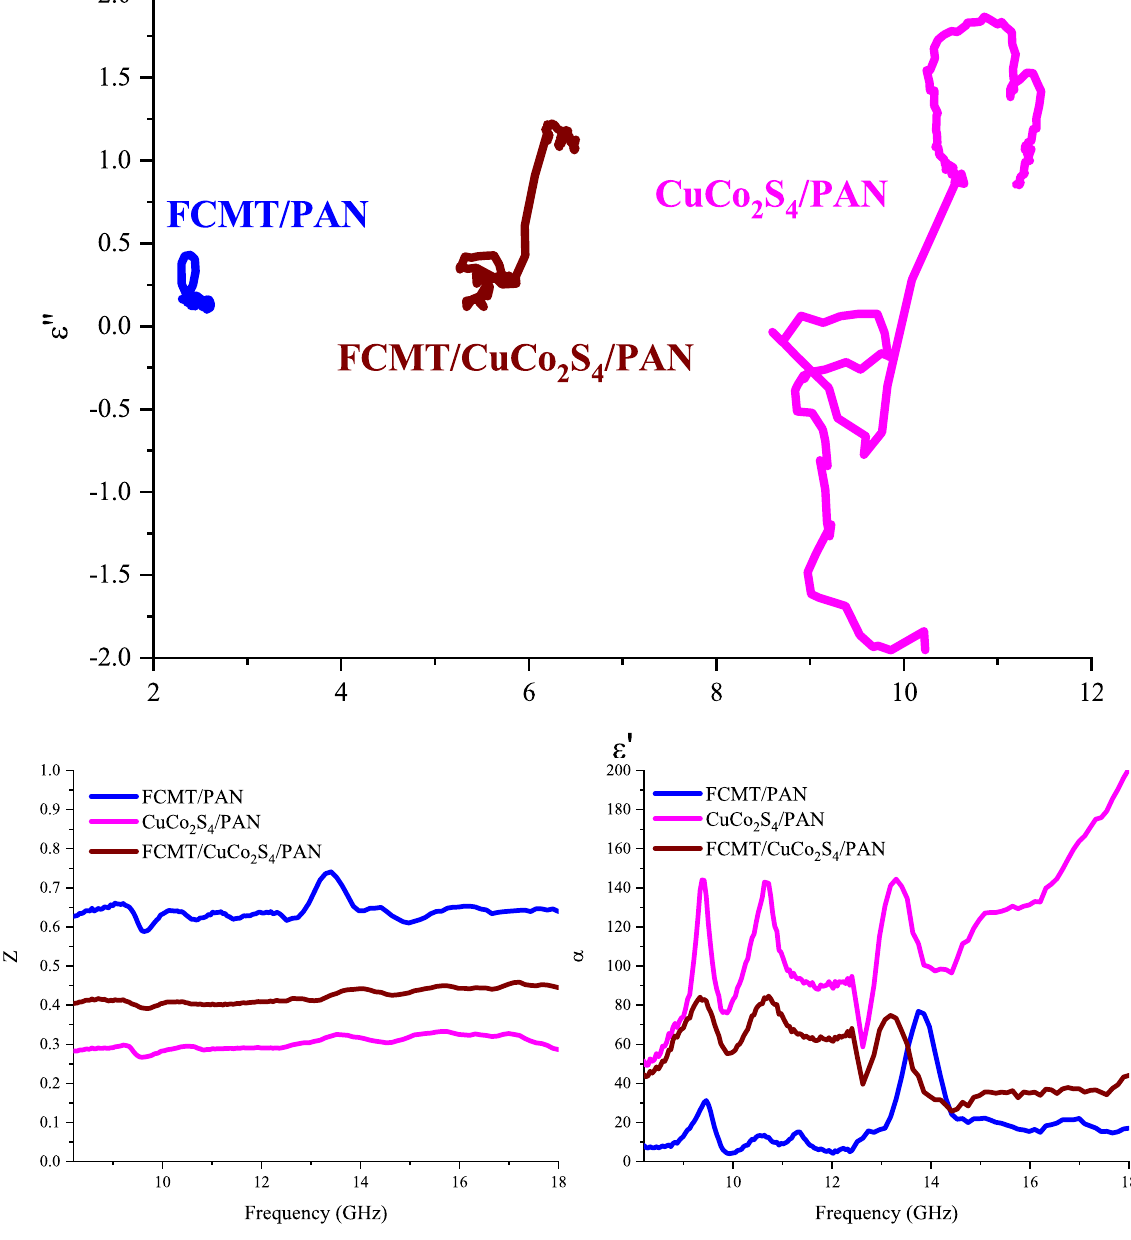
Figure 12. Cole–Cole plot, Z, and α for the tailored